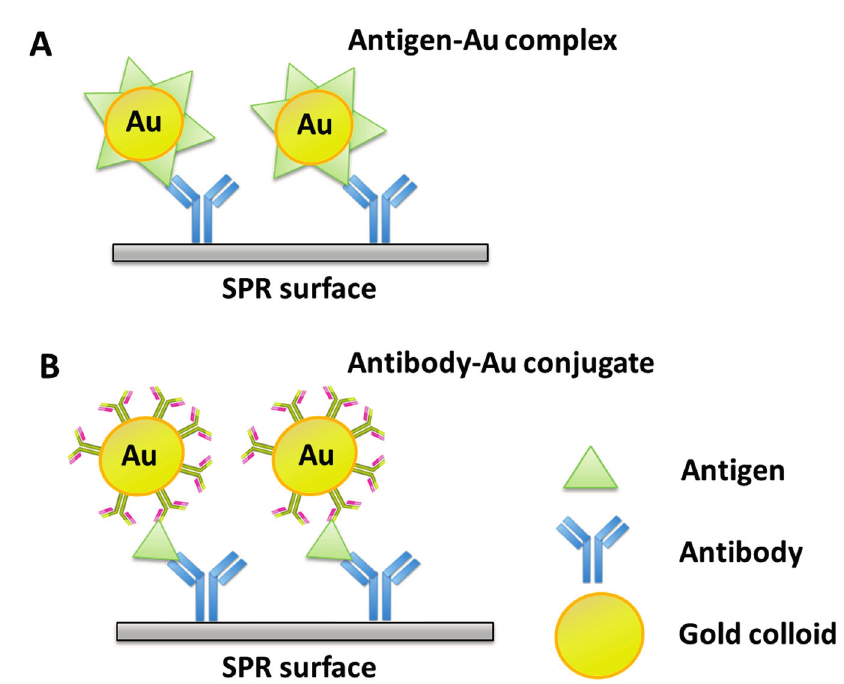
Figure 7. Schematic diagram of an immunochemical molecular recognition to illustrate the utility of Au colloid-enhanced biosensing. Two strategies for particle-enhanced SPR immunosensing are described: ( A ) Direct binding of the antigen-Au complex to an antibody-modified surface; ( B ) Antibody-modified surface followed by binding of a free antigen and then a secondary antibody-Au conjugate. Adapted from